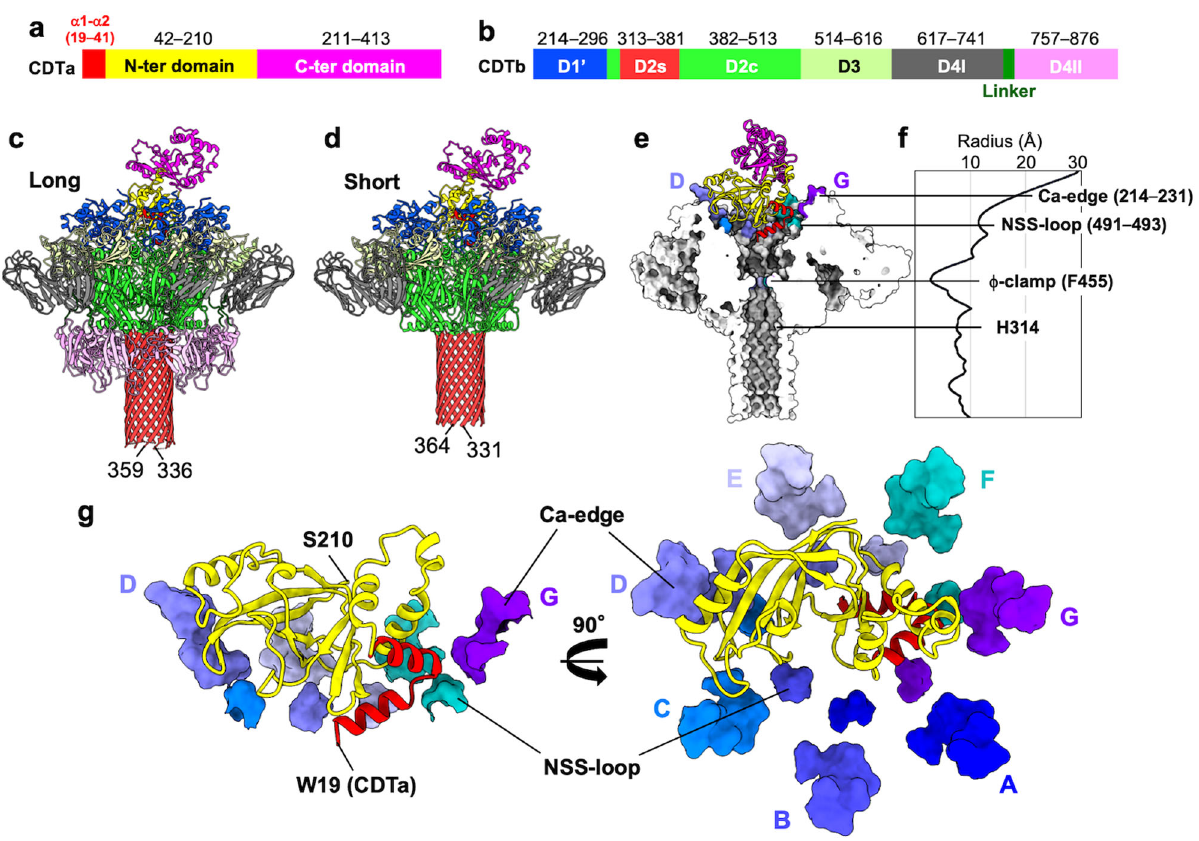
Fig. 3 | Atomic structures of CDTa-bound CDTb-pores. a Domain structure of CDTa. b Domain structureof CDTbafter cleavage ofthe N-terminalpro-sequence. c Structure of long CDTa-bound CDTb-pore. d Structure of short CDTa-bound CDTb-pore. Colors are the same as those in panels a , b . e Cut-away view of CDTa- bound CDTb-pore. CDTb-pore is shown as a surface model, in which Ca-edges are